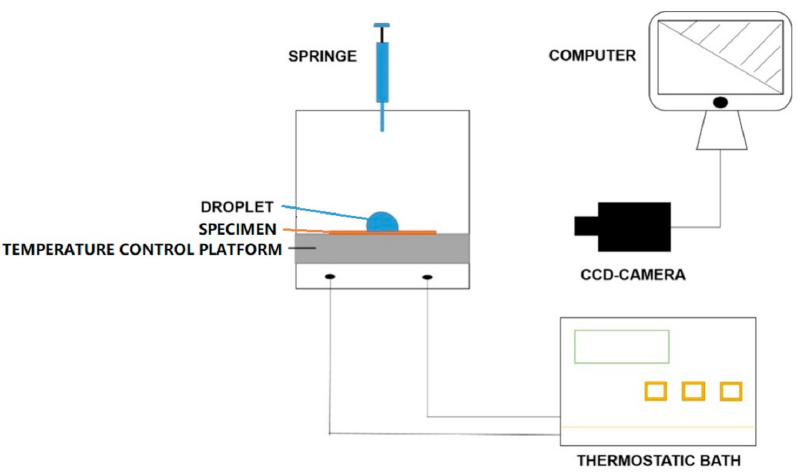
Figure 1. The schematic presentation of modified contact angle testing